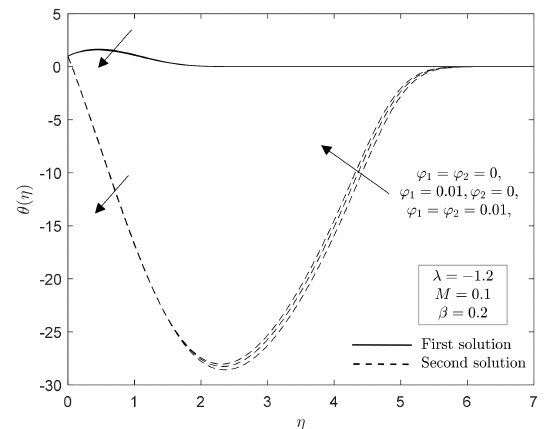
Figure 2. Velocity profile f (cid:48) ( η ) for various value of ϕ 1 and ϕ 2 (Shrinking sheet case) when M = 0.1 and β = 0.2.